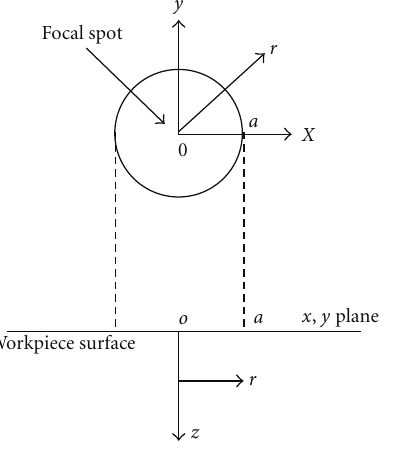
Figure 1: Coordinate system [1].